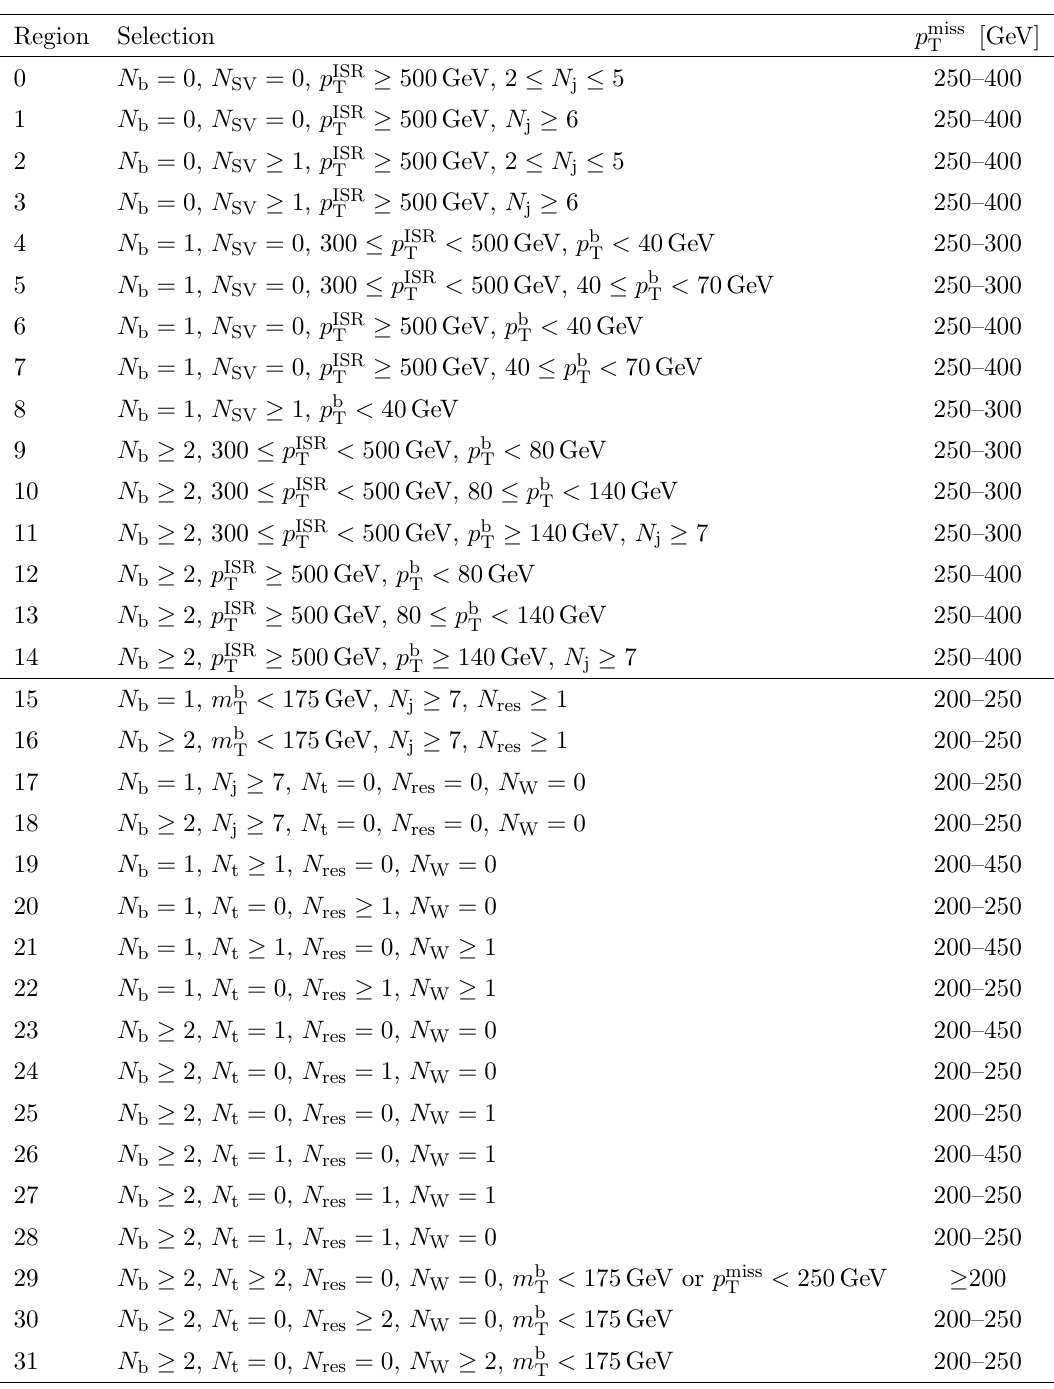
Table 3 . Summary of the validation region selections. The top part of the table (rows 0-14) corresponds to regions for the low (cid:1) m selections, whereas the bottom part (rows 15-31) corresponds to regions for the high (cid:1) m